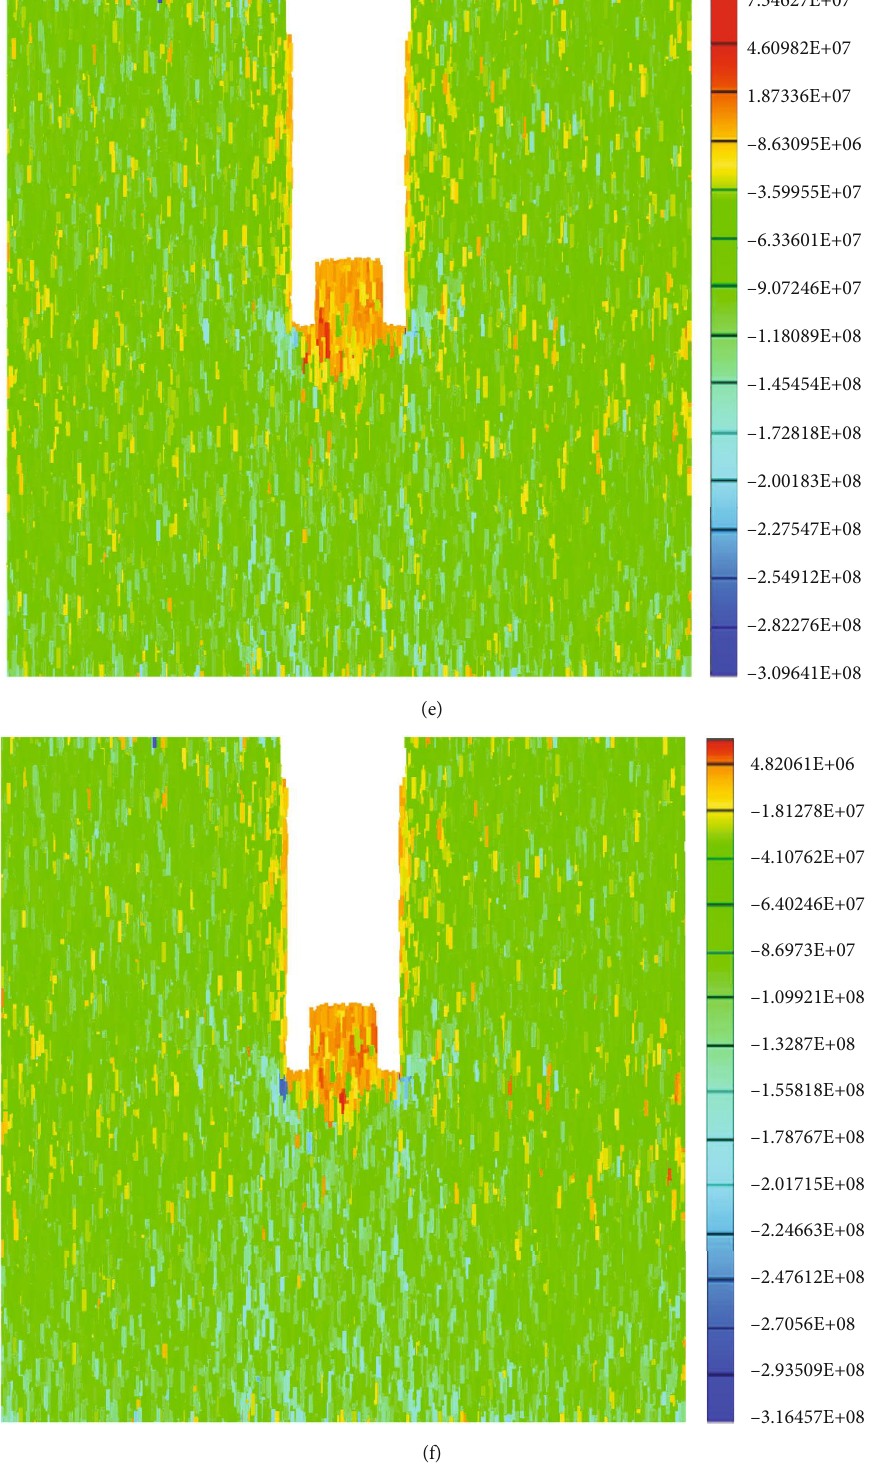
σ σ σ V = H = 60MPa . (b) V = H = 80 MPa . (c) σ σ V = 60MPa, H = 90MPa